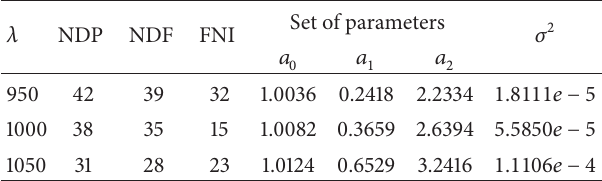
Table 1: Fit parameters of the 𝑓